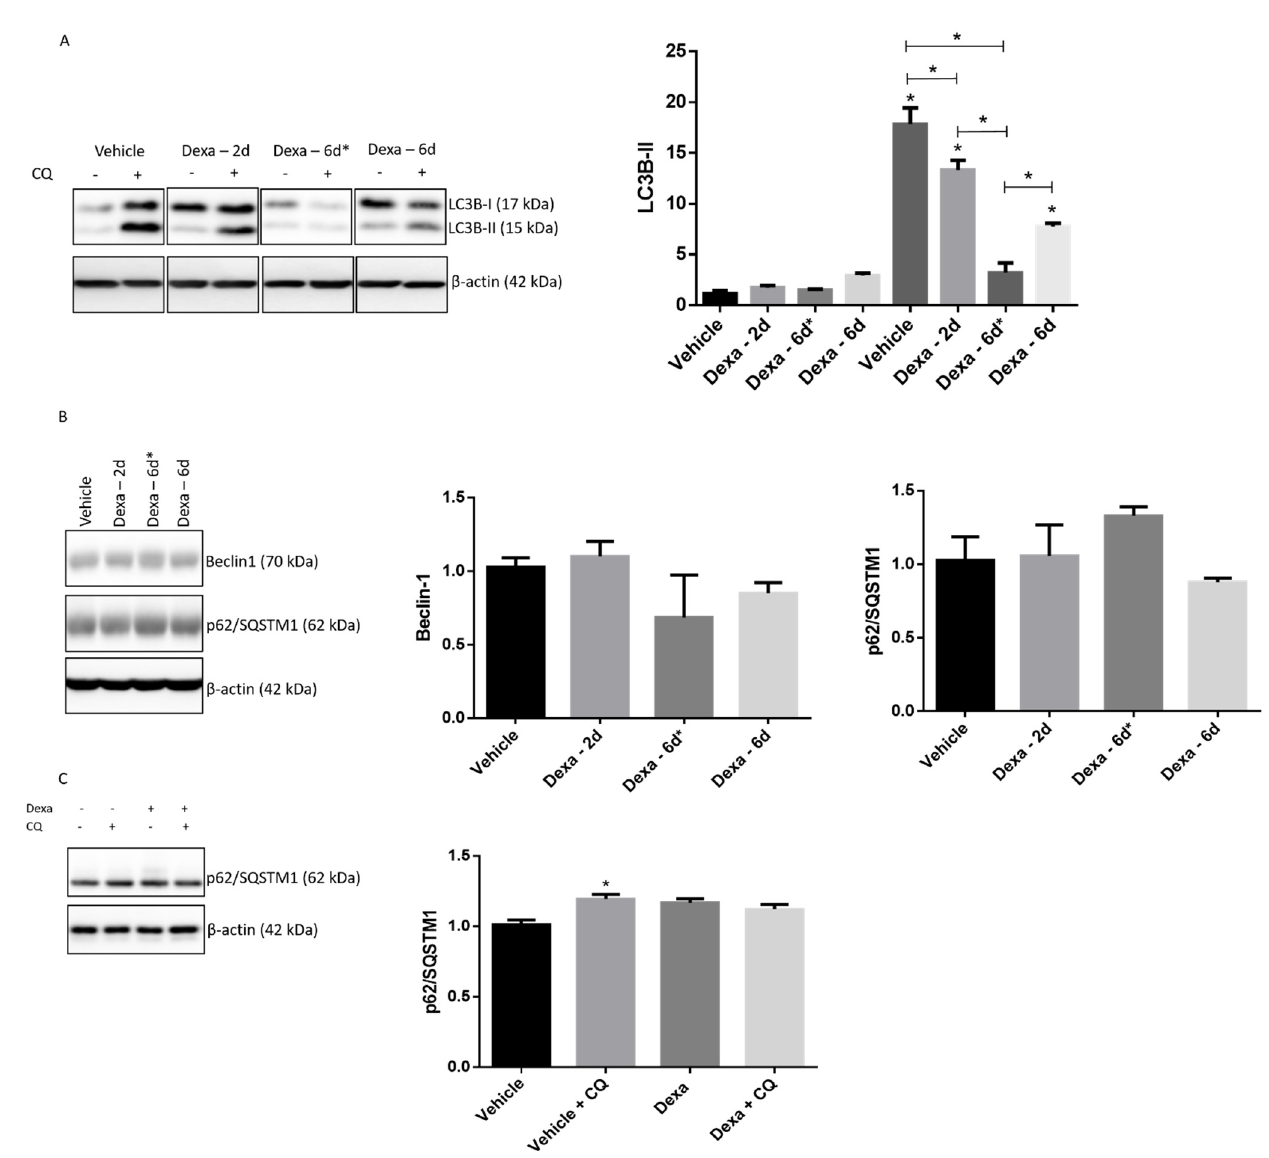
Figure 3. Impaired autophagy flux in Dexa-treated TMCs. Immunoblotting of LC3B in the presence/absence of 20 µM CQ ( A ) and of Beclin-1 and p62/SQSTM1 ( B ) in whole cell lysates of TMCs * p < 0.0001. ( C ) p62/SQSTM1 accumulation in vehicle-treated cells and Dexa-6d* cells in the presence of 20 µM CQ. Normalization in both figures was performed on β -actin. * p < 0.005. A representative experiment of three independent observations is reported ( n = 3); one-way ANOVA followed by Tukey’s post hoc significance test.